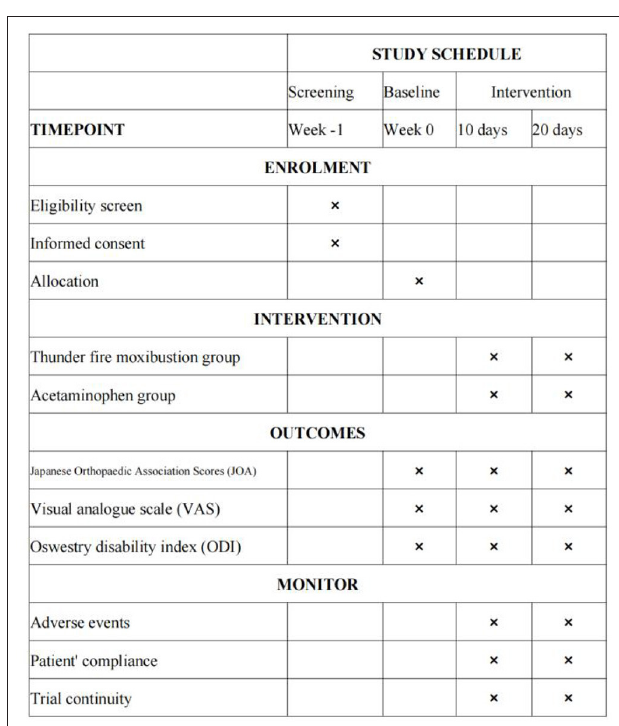
FIGURE 3 | Study schedule. VAS, visual analog scale; ODI, oswestry disability